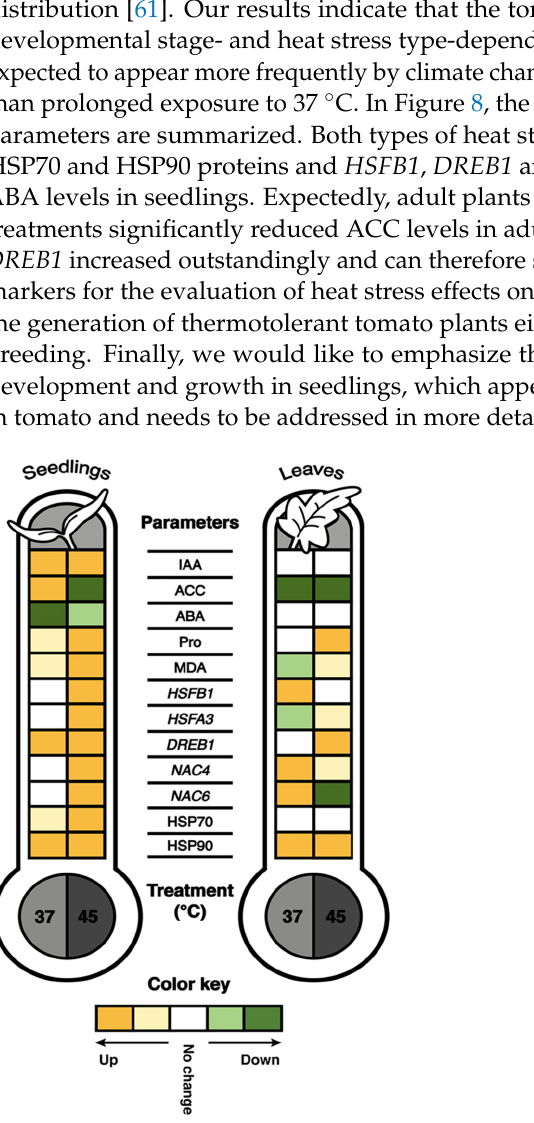
Figure 8. Integrated summary of heat stress effects on all parameters in tomato seedlings and adult plant leaves determined. Prolonged exposure to 37 ◦ C and a short-term treatment at 45 ◦ C were ap- plied. Measured and quantified were phytohormones indol-3-acetic acid (IAA), 1-aminocyclopropane- 1-carboxylic acid (ACC) and abscisic acid (ABA); heat stress markers proline (Pro) and malondi- aldehyde (MDA); heat stress-related transcription factors HSFB1 , HSFA3 , DREB1 , NAC4 and NAC6 expression; and heat shock proteins HSP70 and HSP90 accumulation. Colors indicate changes under heat stress compared to corresponding controls (plants kept at 24 ◦ C). The significant up- or downreg- ulation at p < 0.05 (Tukey’s test) or fold change ≥ 2 (for HSP70 and HSP90) are represented by intense color. Lighter colors indicate a trend of up- or downregulation, while white displays no